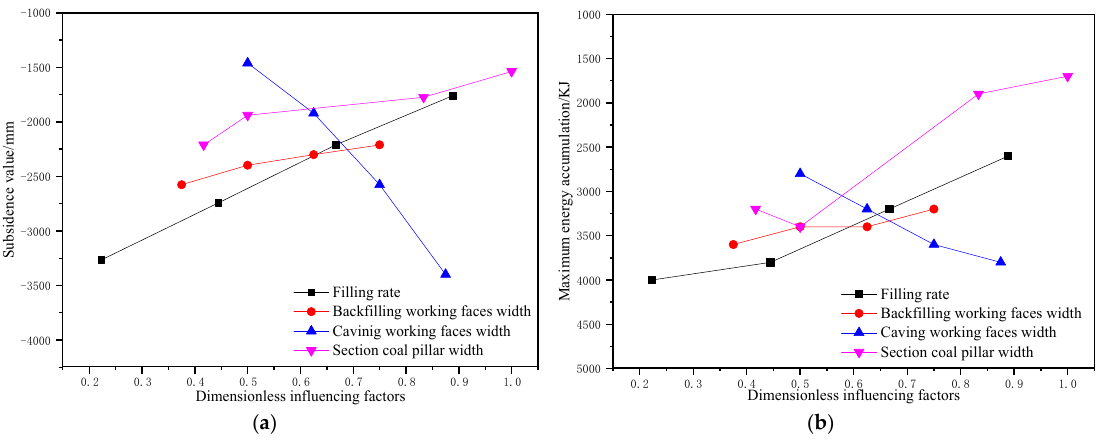
Figure 19. Influence of dimensionless factors on strata movement and energy polling distribution; ( a ) surface subsidence. ( b ) Energy polling distribution.